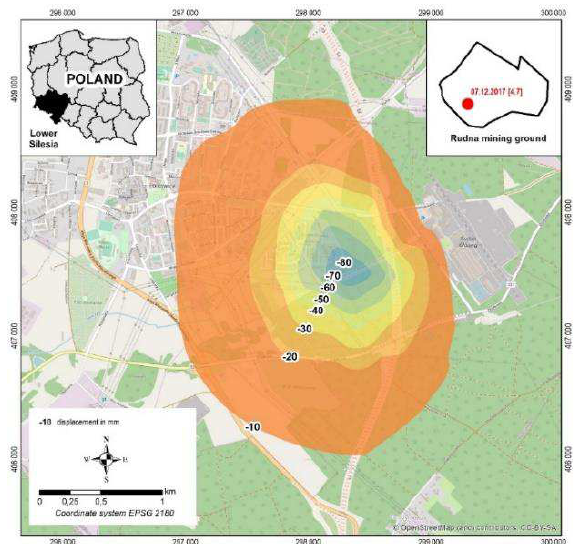
Figure 9. Map of the deformation resulting from the seismic event of 15 September